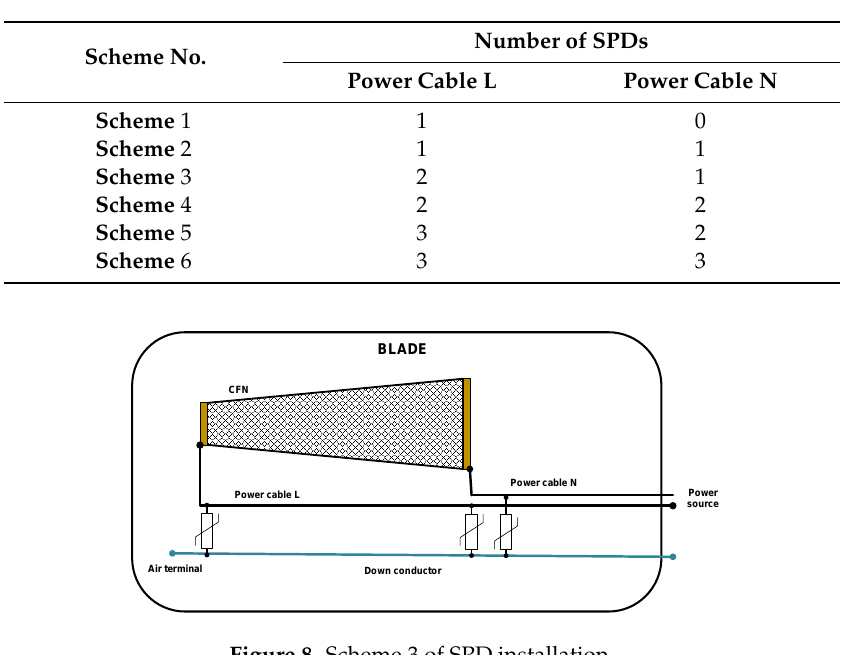
Figure 8. Scheme 3 of SPD installation.